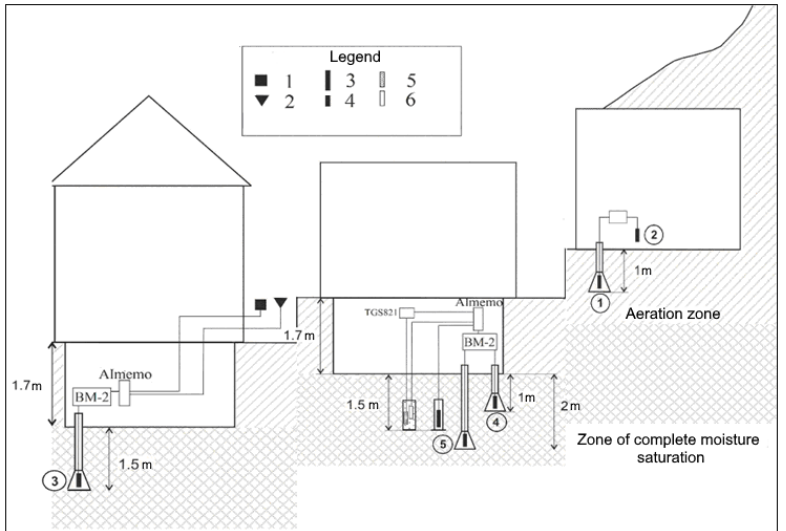
Figure 2. Layout of sensors for recording the concentration of subsoil gases at the PRTR reference point. The numbers in the circles number the gas discharge meters: ( 1 ) pressure sensor; ( 2 ) tempera- ture sensor; ( 3 ) gas-discharge counters β -radiation; ( 4 ) sensor γ radiation; ( 5 ) molecular hydrogen sensor; ( 6 ) carbon dioxide